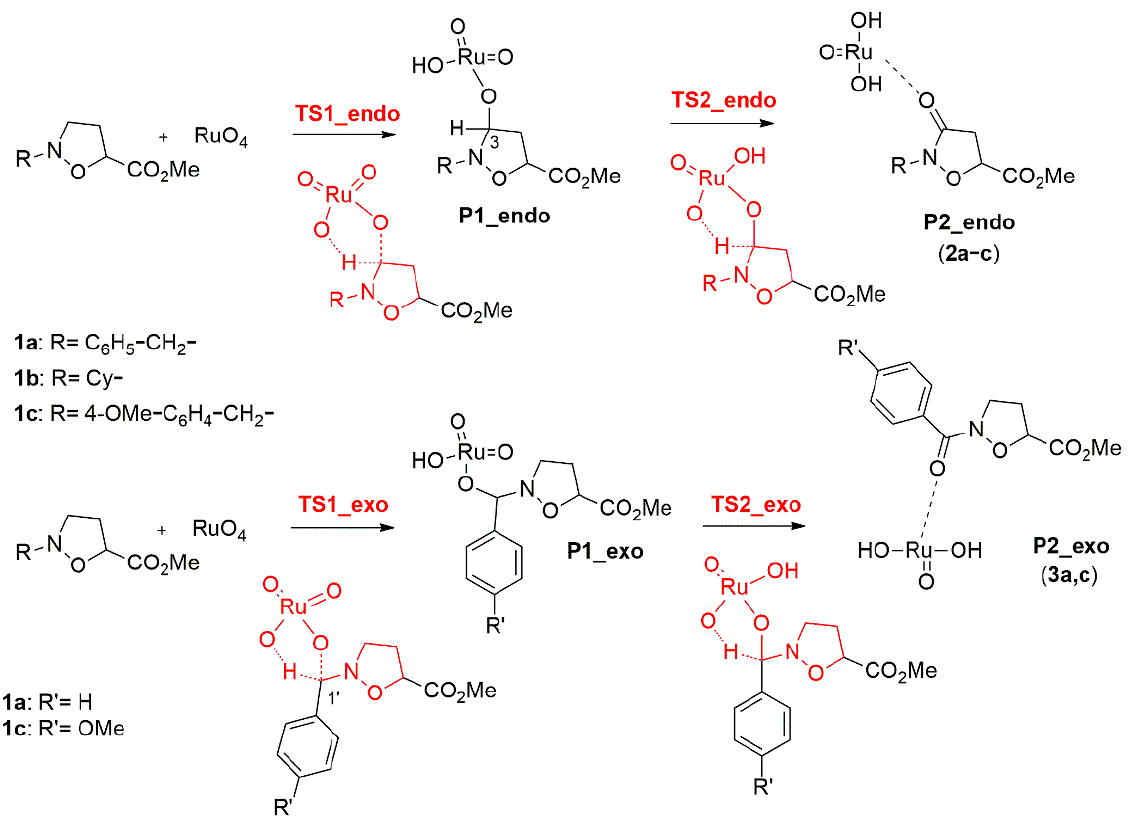
Scheme 1. Reaction mechanism of oxidation with RuO 4 of compounds 1a–c in α position to the nitrogen atom. Table 1. Relative free energies (kcal/mol) of TSs and percentages of the corresponding products at 298 K of the oxidation reaction with RuO 4 of compounds 1a–c